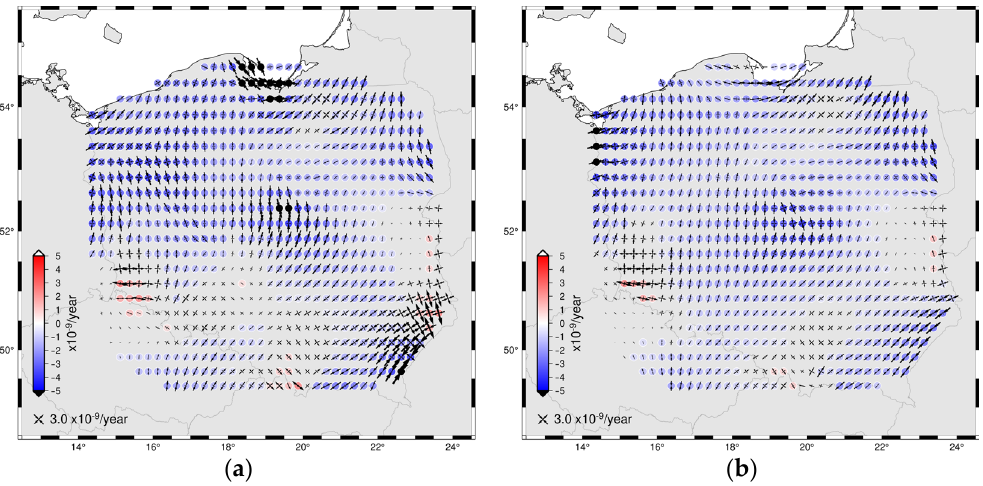
Figure 8. GPS strain rate maps including dilatation strain for SBF_15 ( a ) and SBF_25 ( b ).